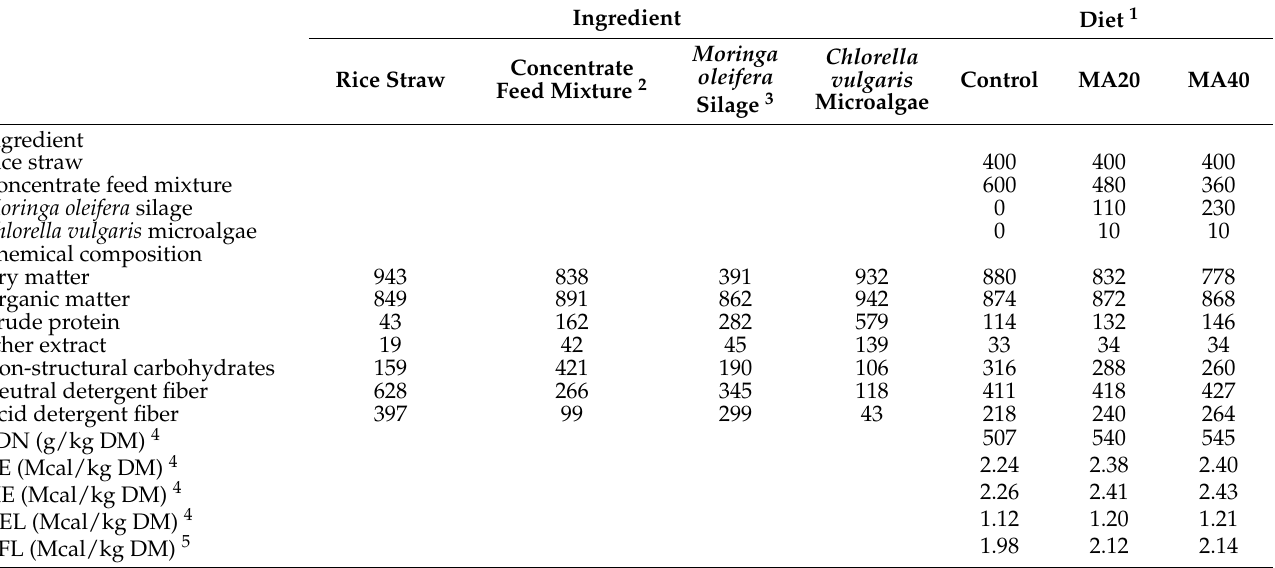
Table 1. Ingredients (g/kg DM) and chemical composition (g/kg DM) of total mixed rations fed to the lactating Damascus